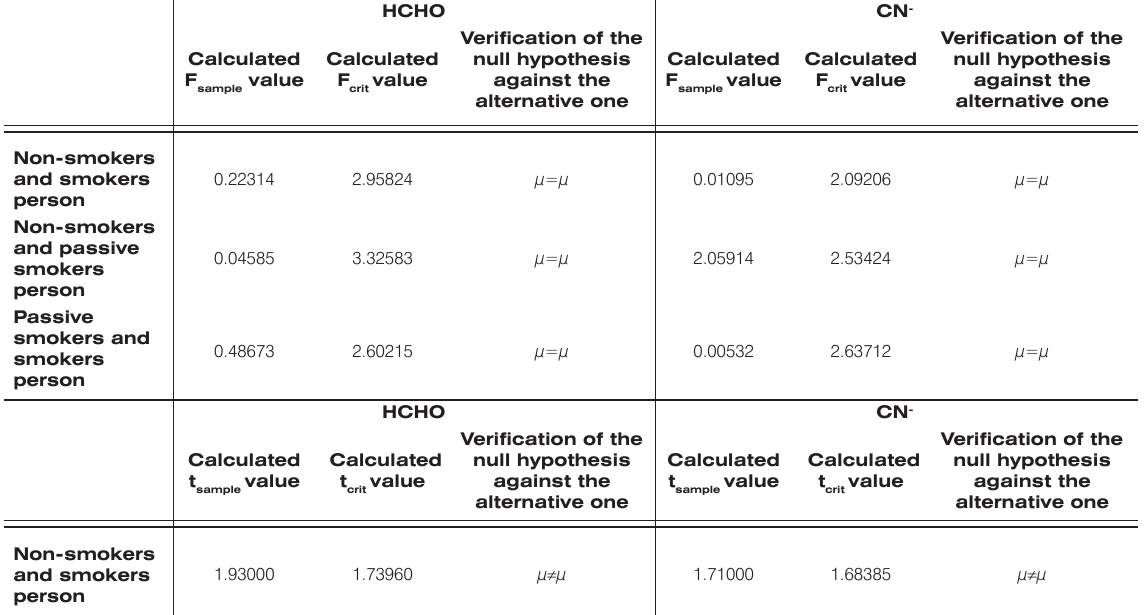
of interfering ions on the determination of formaldehyde and cyanide ion with the optimal reactant concentrations.